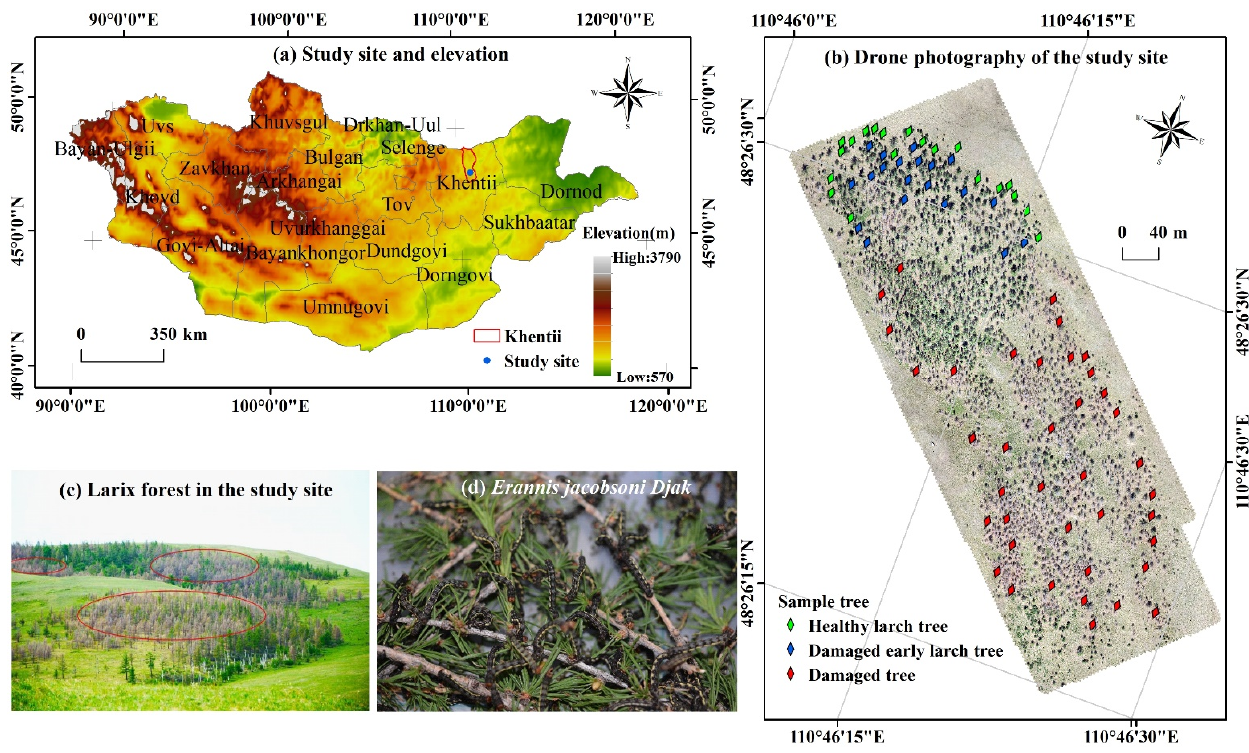
Figure 1. ( a ) Study area in Mongolia: Elevation ( b ) Drone photography of the study site; distribution of sample tree ( c ) larch forest in the study area; ( d ) Jas’s Larch Inchworm ( Erannis jacobsoni Djak).